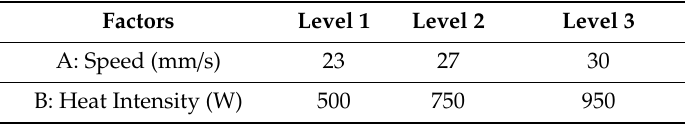
Table 2. Factors and levels for line scan experiment.